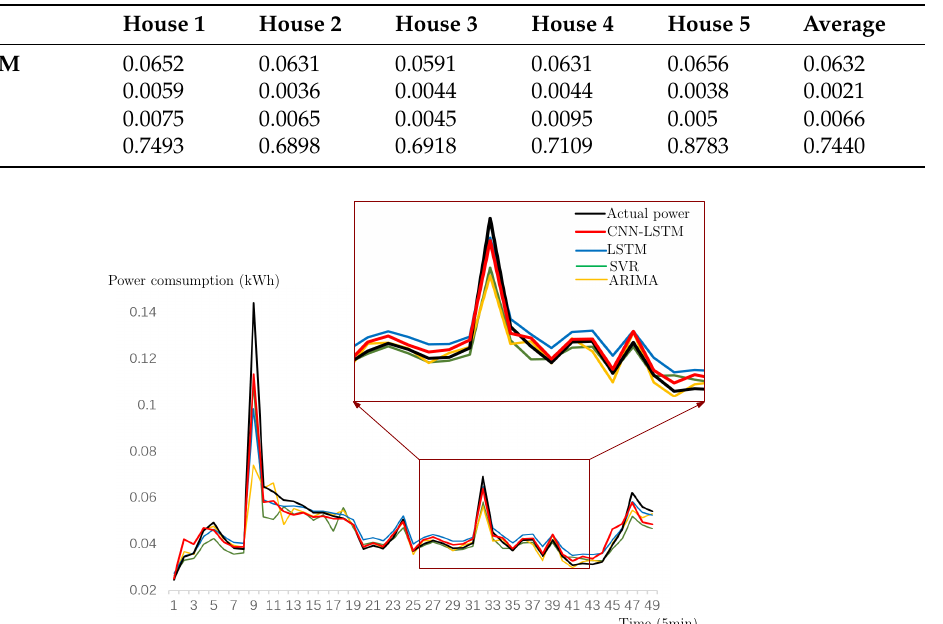
Table 2. Averaged computational time (in seconds) taken by CNN-LSTM, LSTM, SVR and ARIMA models for each predicted data point.